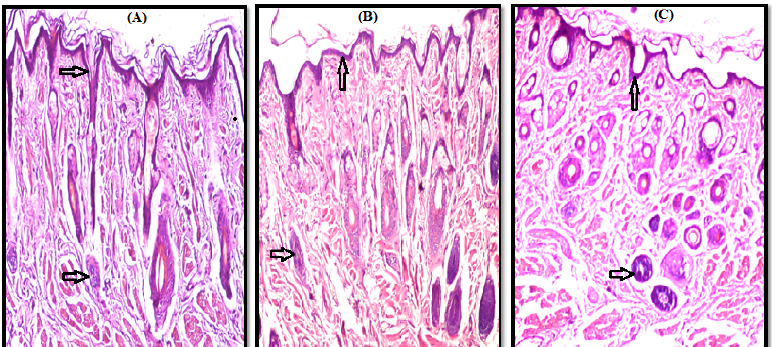
Figure 4. Photomicrograph of nasal vestibule showing a normal histological structure of surface epithelium and subepithelial glands as shown by arrows, ( A ) Control, ( B ) F1, and ( C ) F17.